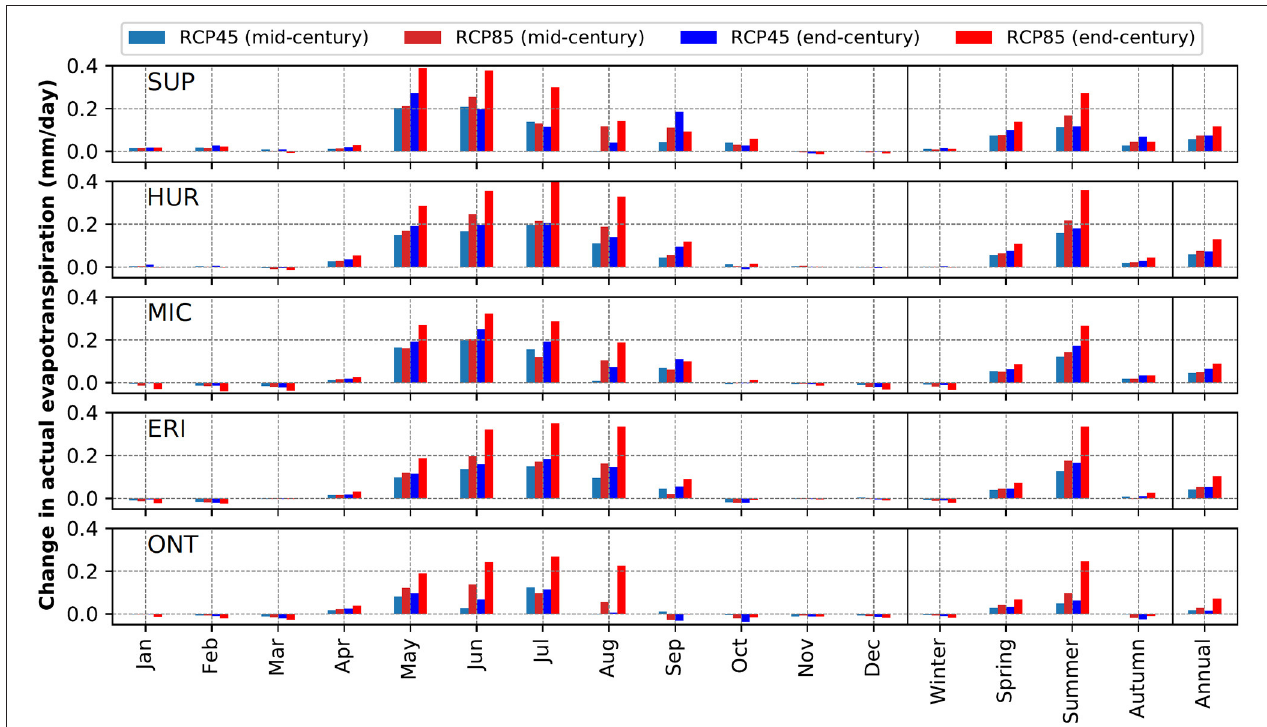
FIGURE 12 | Absolute changes in monthly, seasonal, and annual actual evapotranspiration (AET) with respect to the baseline values for RCP 4.5 and RCP 8.5 scenarios in both mid- and end-century periods.